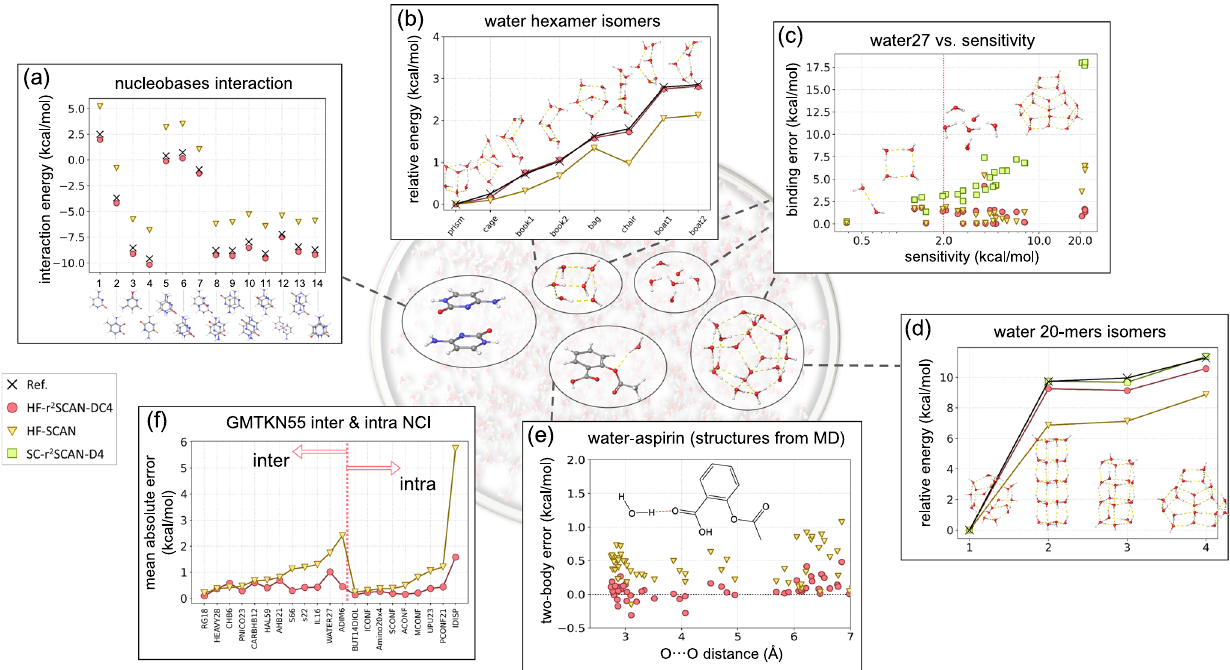
Fig.1|PerformanceofHF-r 2 SCAN-DC4relativetoHF-SCANforvariouschemical reactions. Atomcolorcode:C,gray;O,red;N,blue;and H,white. a theinteraction energy of various con fi gurations of the stacked cytosine dimer, where HF-SCAN underbinds by 2 – 3kcal/mol; b energies of water hexamer relative to the lowest- lying prism isomer, with HF-SCAN underestimating by up to 1kcal/mol; c errors in binding energy of WATER27 complexes as a function of density sensitivity (how much a DFT energy changes when the density is changed), showing how large errorscan be without using the HFdensity.One cluster,H 3 O + (H 2 O) 6 OH − (at x close